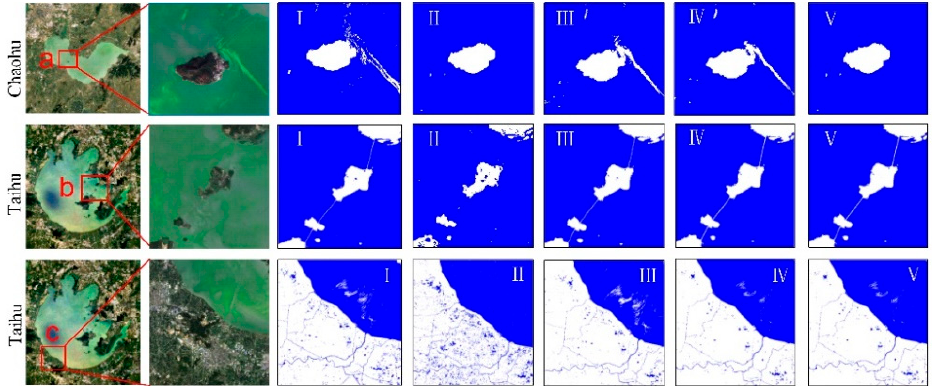
Figure 12. Comparison of LWB extraction in polluted lakes for Methods I–V. The subpictures a , b , c of Figure 12 are used to show the differences among the extraction results.